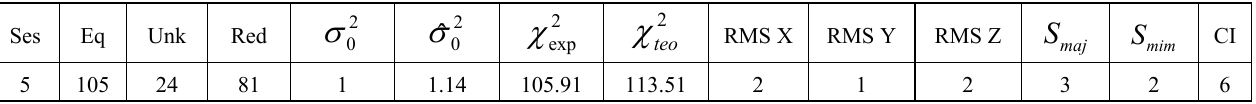
Table 3. Minimum constrained adjustment